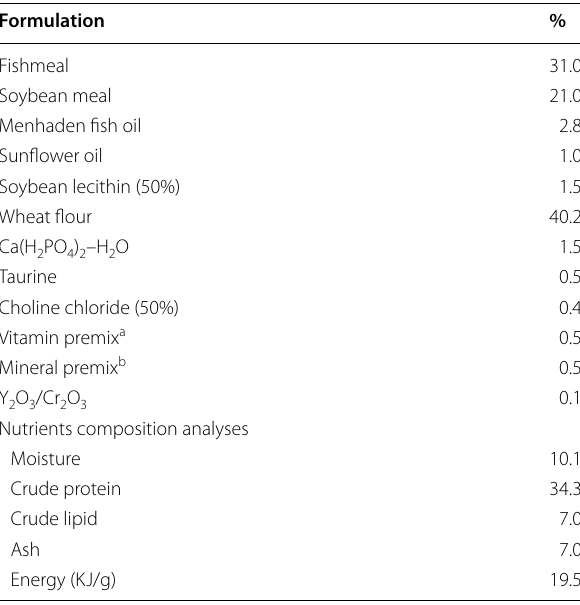
Table 1 Formulation and proximate composition of Ref diet